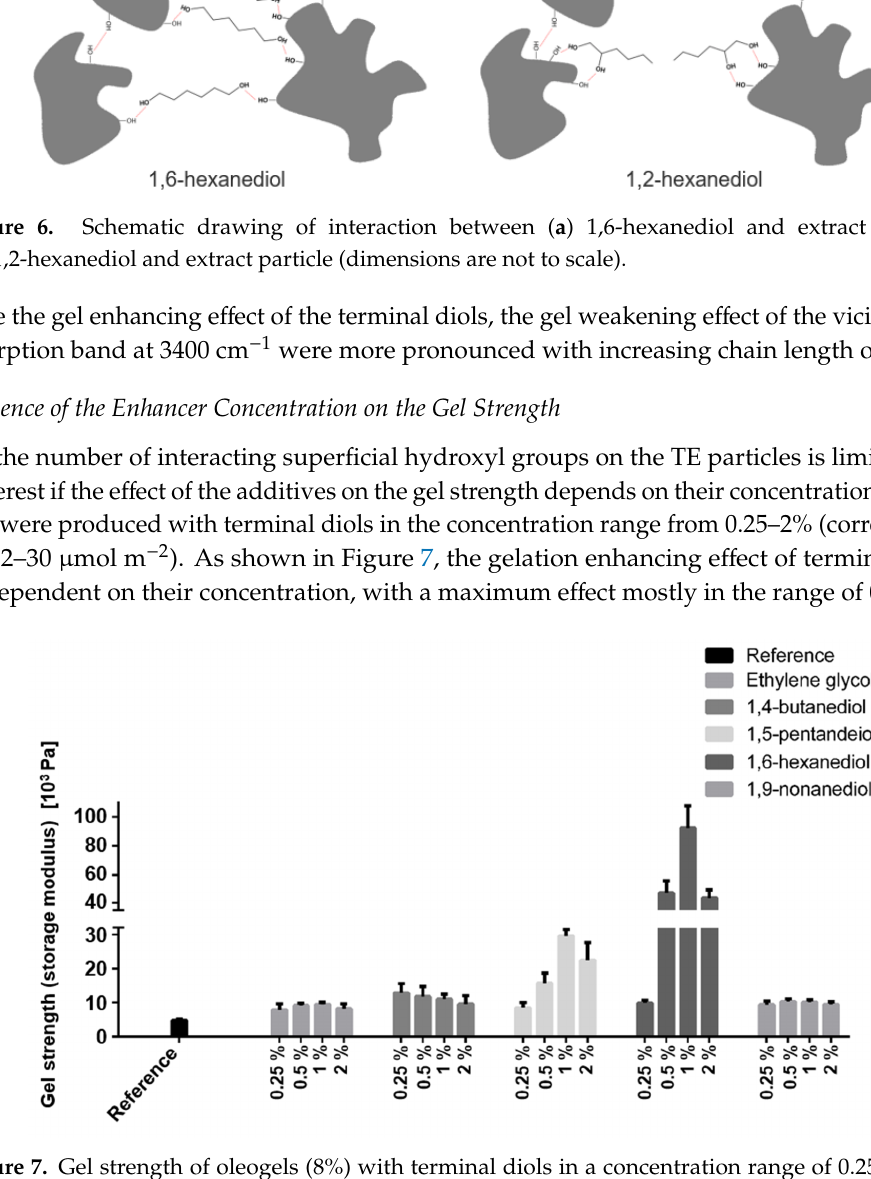
Figure 5. IR spectra of oleogels (8% TE) in sunflower oil with vicinal diols and their corresponding terminal diols (2%) .